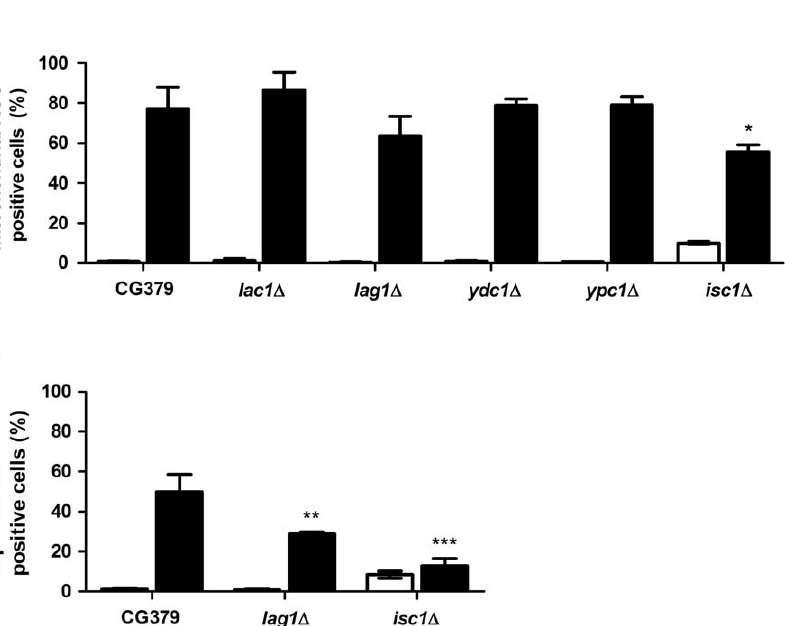
Figure 3. Intracellular ROS. Levels of mitochondrial ROS (A) and superoxide anion (B) in the indicated S. cerevisiae strains exposed to 180 mM acetic acid, pH 3.0, for 0 min (white columns) and 200 min (black columns), using MitoTracker Red CM-H 2 XRos (A) and DHE (B), respectively. Values are mean + SD of at least three independent experiments. Values significantly different from CG379: * P , 0.05, ** P , 0.01 and *** P , 0.001, One-way ANOVA and Tukey Test.